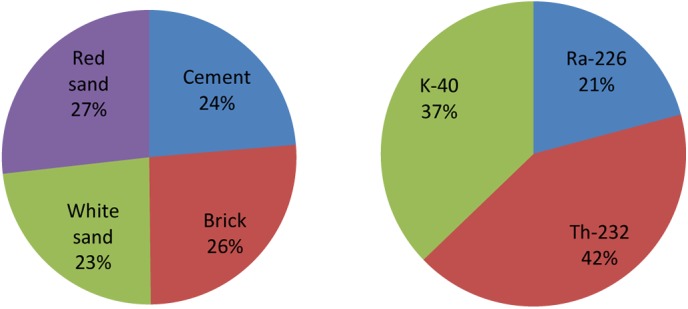
Dose contribution due to the content of 226Ra, 232Th and 40K in building materials to the inhabitants.